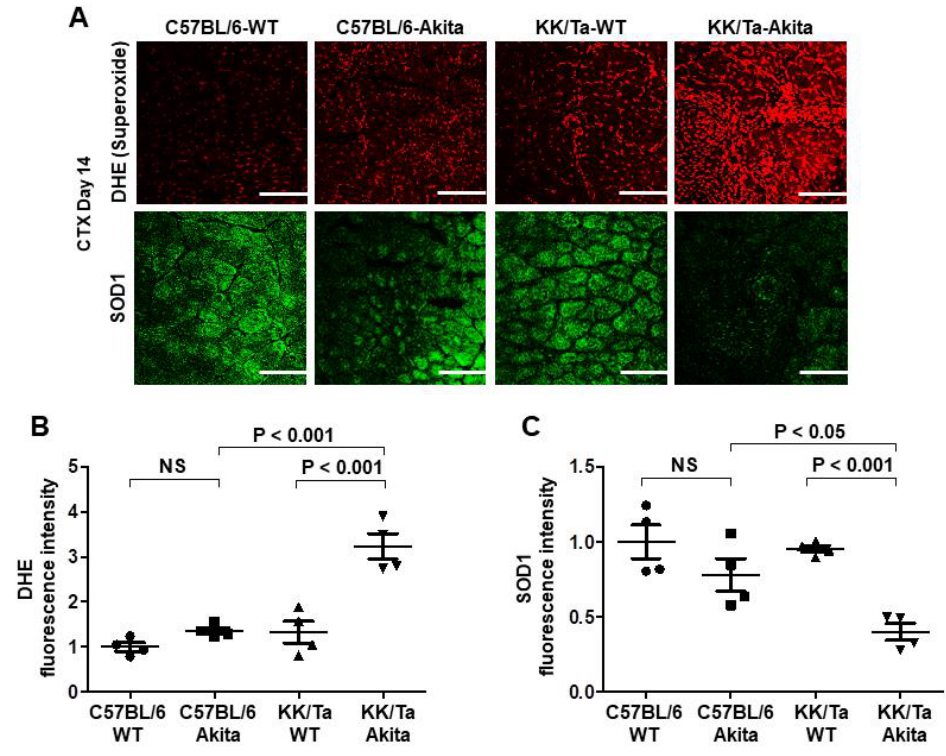
Figure 4. Changes in superoxide production and SOD1 expression in TA muscles on day 14 after CTX injection. ( A ) Representative images of DHE and SOD1 immunofluorescent stainings in TA muscles on day 14 after CTX injection. The degree of superoxide production was evaluated by DHE fluorescence intensity. Bars = 200 µ m. ( B ) The average semiquantified fluorescence intensity of DHE staining. DHE fluorescence intensity was assessed in 6 TA muscle regions per mouse, and the average value was calculated in each mouse. ( C ) The average semiquantified fluorescence intensity of SOD1 immunofluorescent staining. SOD1 fluorescence intensity was assessed in 6 TA muscle regions per mouse, and the average value was calculated in each mouse. Data are presented as means ± SEM. n = 4 per group.